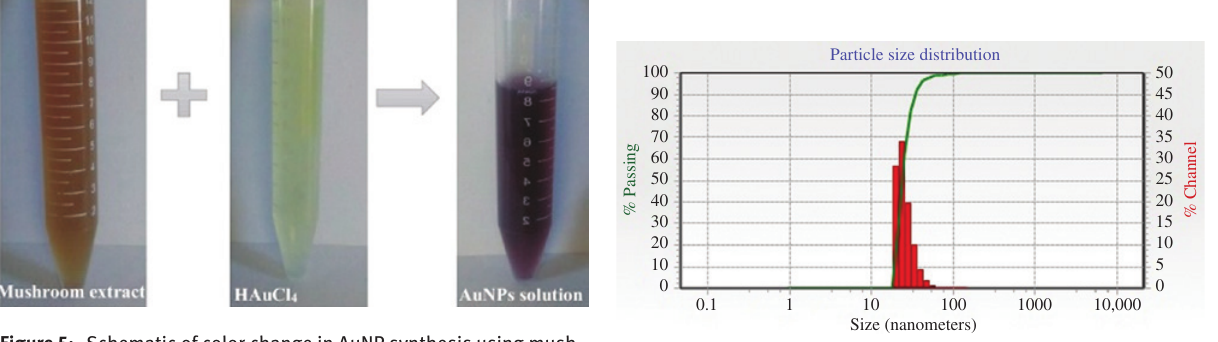
Figure 5: Schematic of color change in AuNP synthesis using mush- room extract.